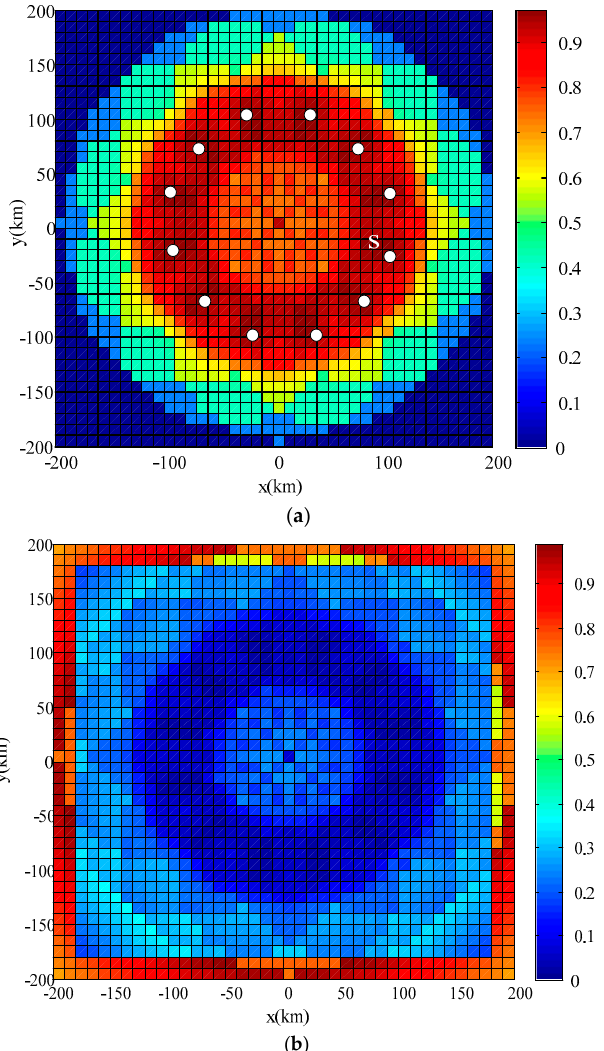
Figure 5. Sensor deployment before optimization. ( a ) Target detecting probability distribution; ( b ) target detecting risk distribution.